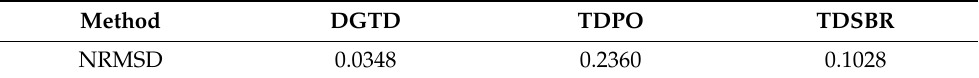
Figure 10. Accuracy comparison of DGTD, TDPO and TDSBR methods for RCS calculation at 1 GHz of multi-scale structural objects. Table 3. The NRMSD of DGTD, TDPO and TDSBR for the multi-scale object at 1.5GHz.